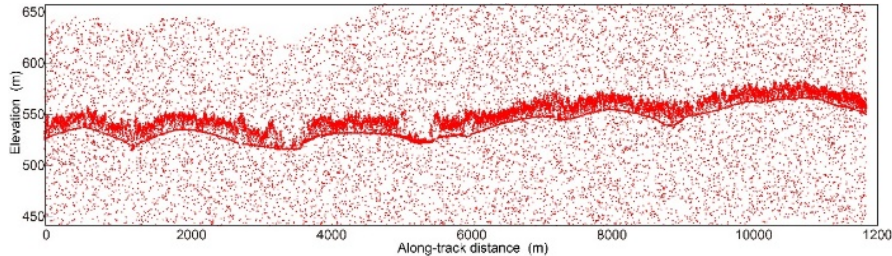
Figure 2. Original photons acquired by the ICESat-2 system.